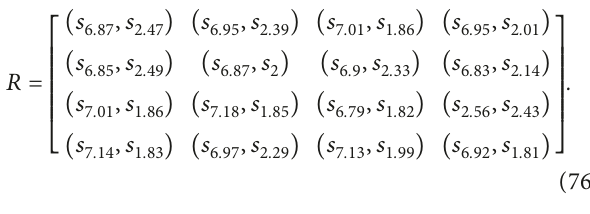
Table 15: Normalized decision matrix R